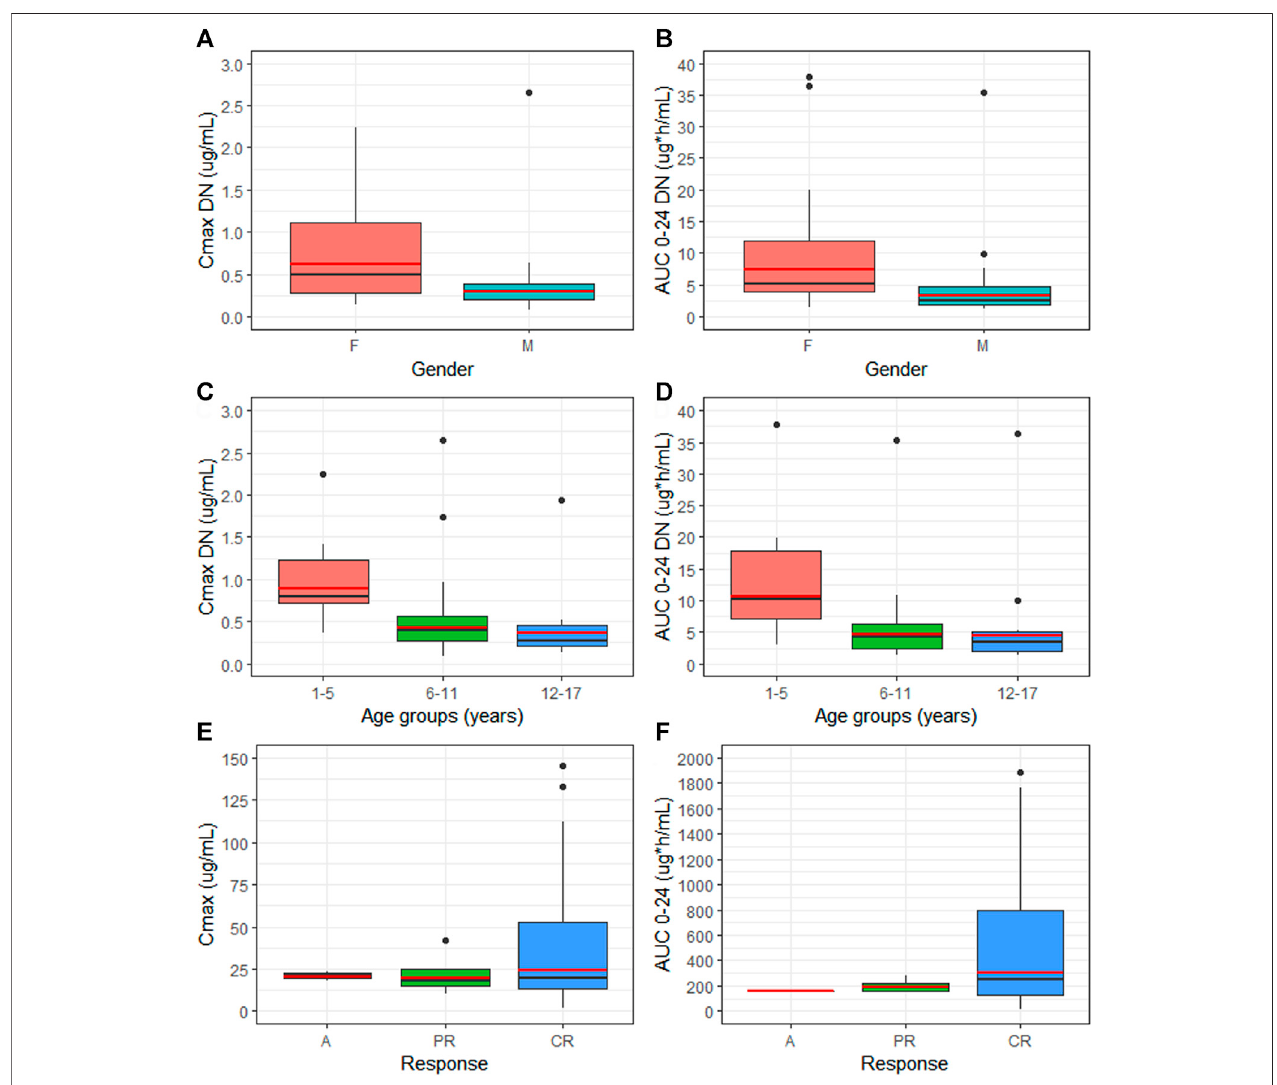
FIGURE 3 | Comparison of median (black line) and geo-mean (red line) of dose-normalized Cmax (Cmax DN) and dose-normalized AUC 0 – 24 (AUC 0 – 24 DN) between gender (A,B) and different age groups (C,D) . Median (black line) and geo-mean (red line) of exposure parameters between patients with distinct EPAG response (E,F) . M (cid:2) male, F (cid:2) female, C (cid:2) complete response, PR (cid:2) partial response, A (cid:2) no response.